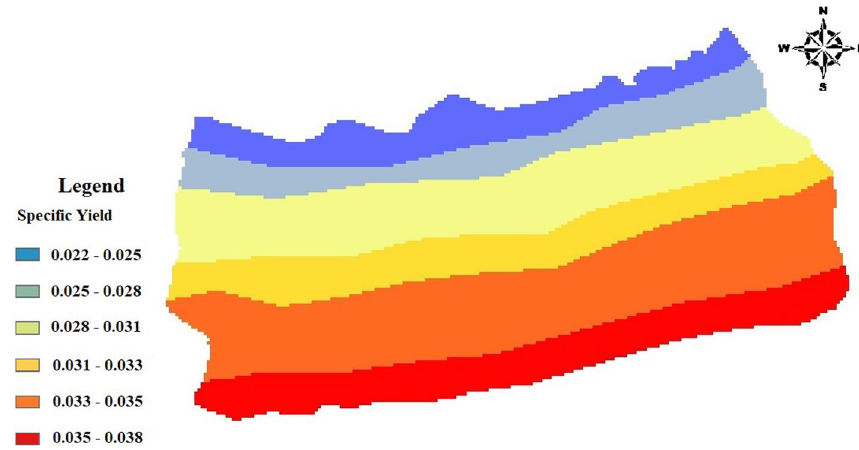
0.9990.99910.99920.99930.99940.99950.99960.99970.99980.99991 Fig. 5 Monthly time series of Willmott’s index of agreement in cali- bration and validation periods of qualitative model Fig. 6 The spatial distribution of specific yields in the study area